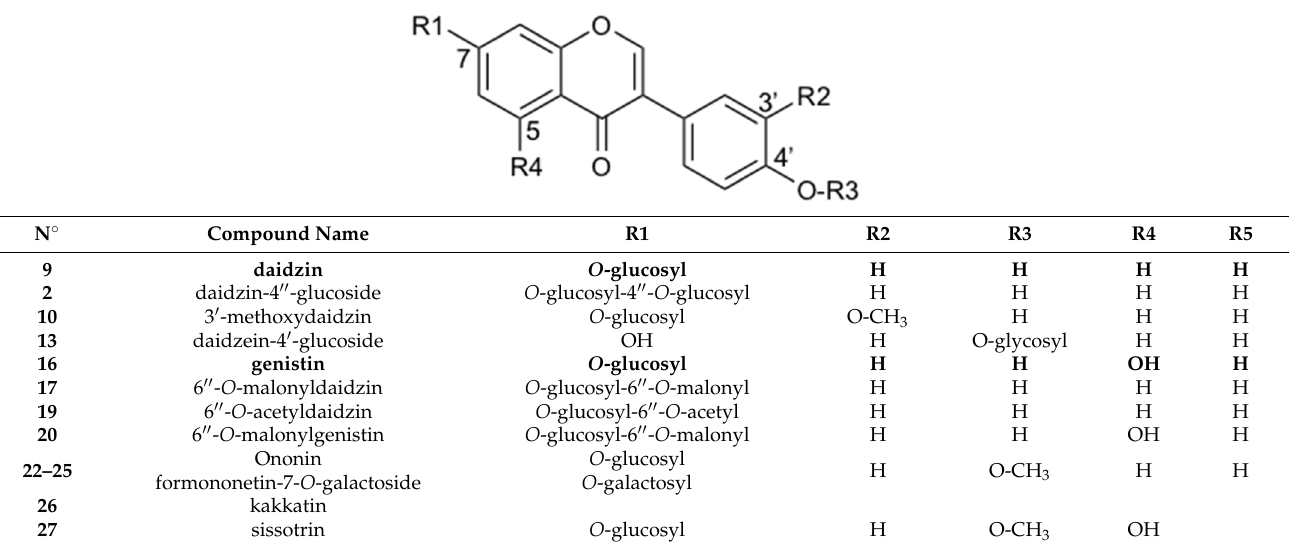
Table 4. Structure of annotated isoflavone O -glycosides. Table 4. structure of annotated isoflavone O